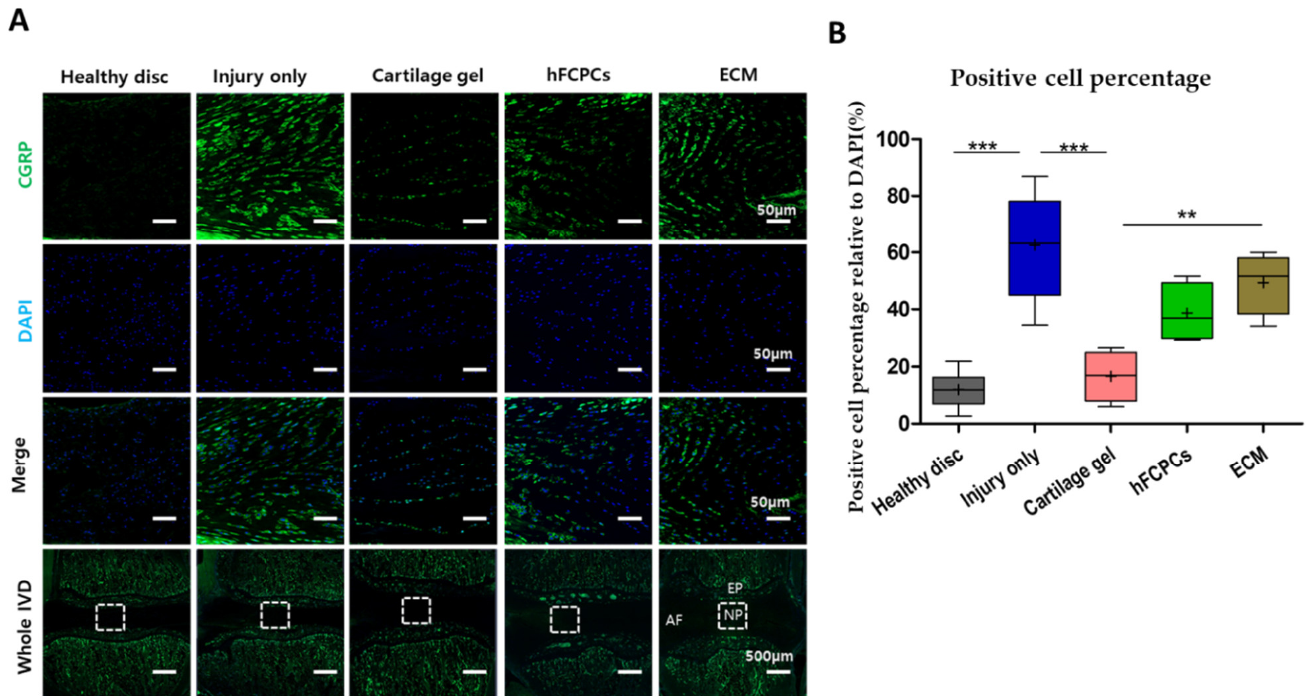
Figure 7. Cartilage gel inhibited injury-induced pain in the disc nucleus pulposus (NP) of a rat tail nucleotomy model. ( A ) Immunofluorescence of rat tails of cartilage gel-injected, hFCPCs-injected, ECM-injected, healthy, and injury-only discs at six weeks after nucleotomy for CGRP (green), DAPI (blue), and merged signals. ( B ) Changes in the percentage of CGRP-positive cells in the disc NP spaces. Immunopositivity was counted in the disc NP with low-power fields and calculated as relative to the total number of DAPI-positive cells. Data are presented with box plots ( n = 4, ** p < 0.01, *** p < 0.001, significant difference by one-way ANOVA). hFCPCs, human fetal cartilage-derived progenitor cells; ECM, extracellular matrix; CCRP, calcitonin gene receptor protein.